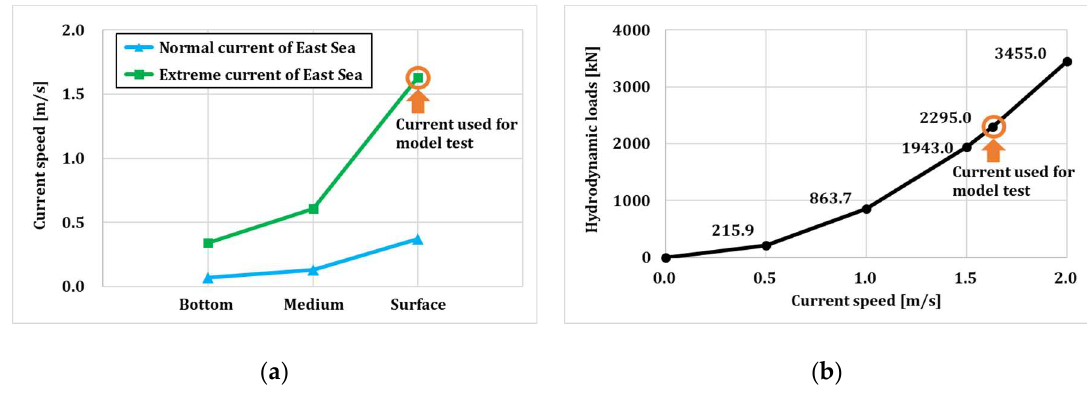
Figure 5. Current speed by depth ( a ) and hydrodynamic load by current ( b ).